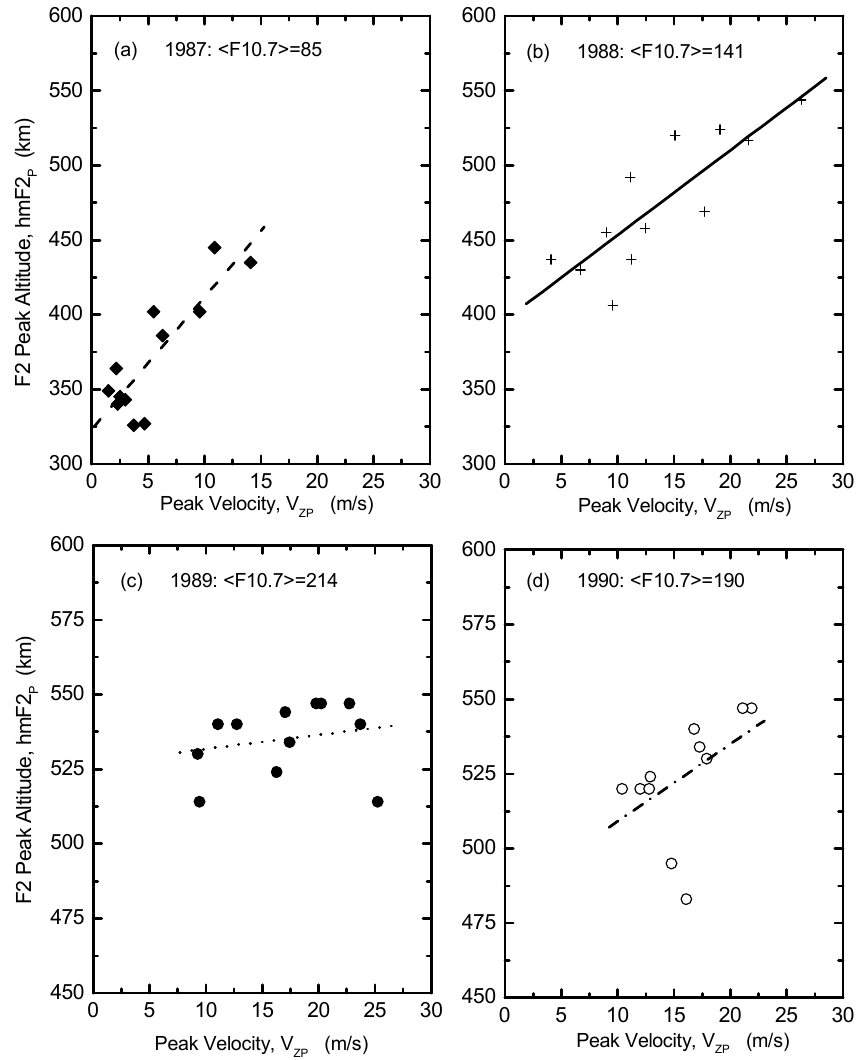
Fig. 2. Dependence of ionospheric peak F2 maximum height ( hm F2 P ) on the evening pre-reversal enhancement in vertical ion drift. The average decimetric solar flux for each year is indicated on each